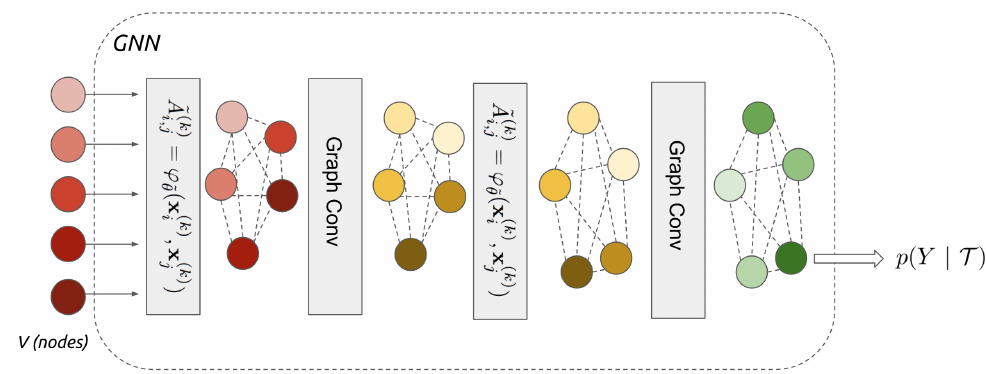
Figure 3. graph neural network for representation learning. Note: dotted lines indicate learnt edge features and node colour changes indicate the aggregation of information by convolutional layers. Reproduced with permission